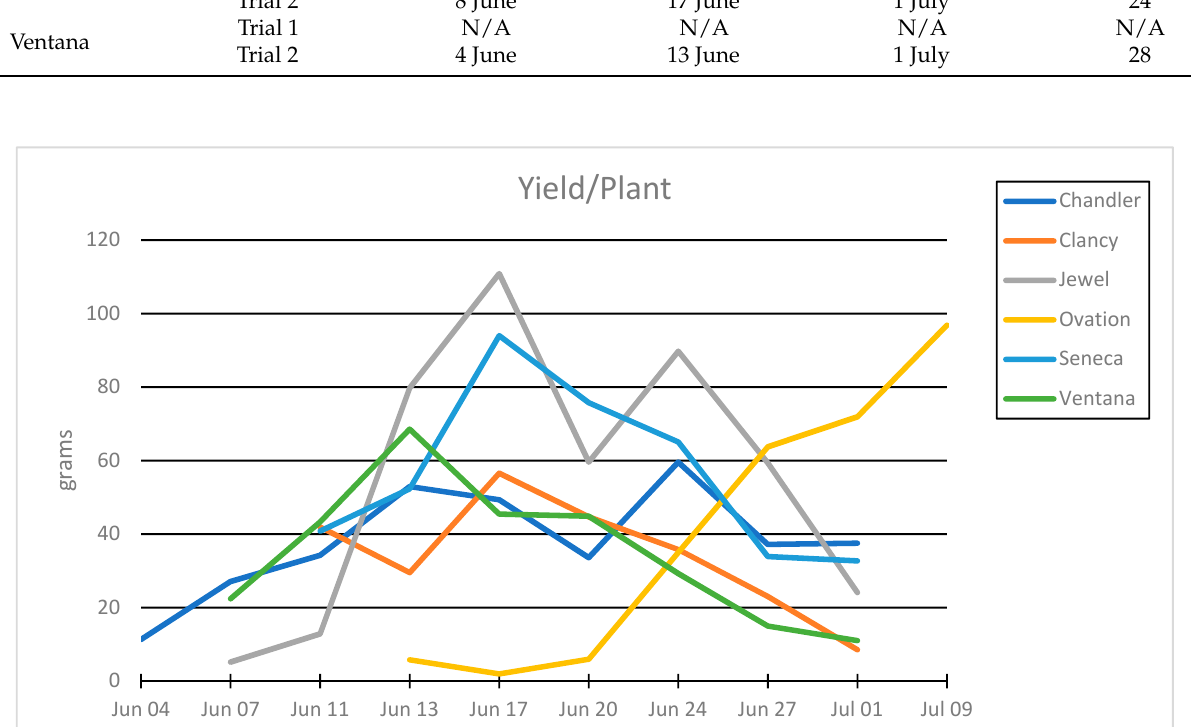
Figure 5. Mean total per plant yield through the harvest season for six short-day varieties in Trial 2 harvested in 2014 in an annual plasticulture production system in a cold climate region (central NY). More typical spring temperatures pushed peak production later into June.